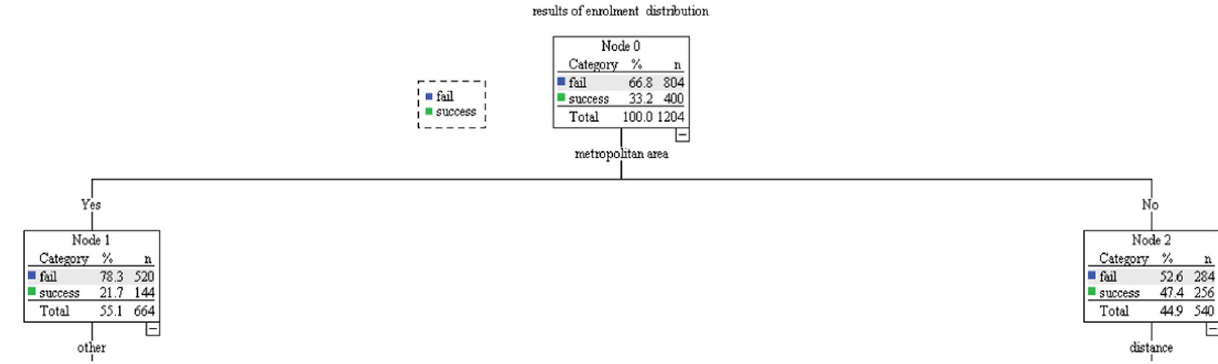
Fig. 4 A sub-tree on up for the test. A sub-tree structure of the fi rst to the second level for the test sample.